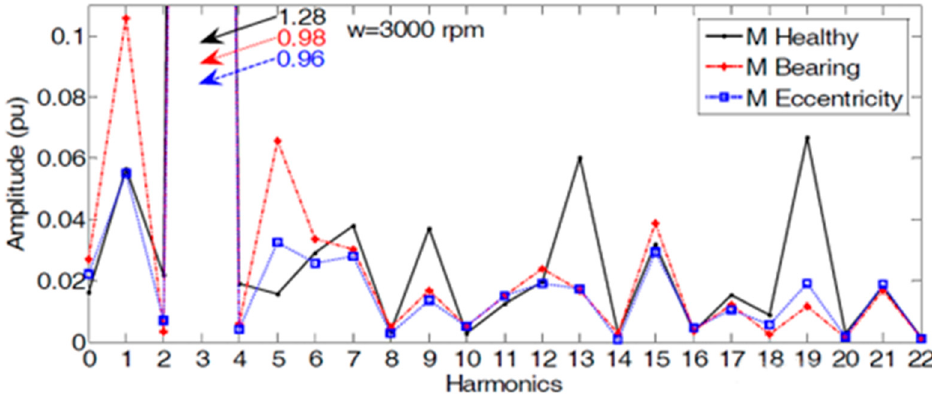
Figure 7. Stator current spectrum to diagnose bearing faults (redline) and eccentricity faults (blueline) in PMSM [16].